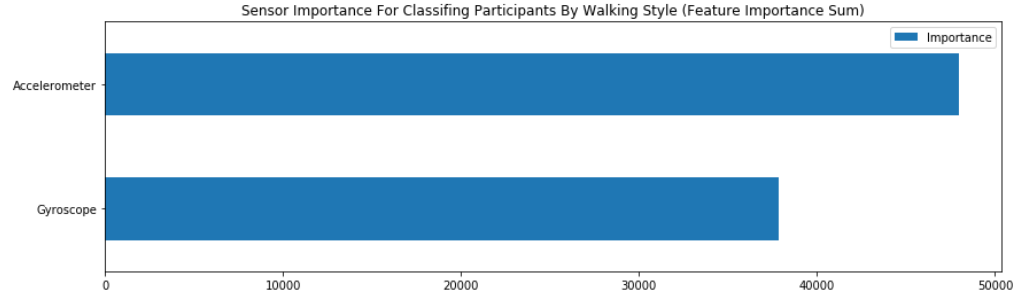
Figure 2. Sensor importance for classifying activities.